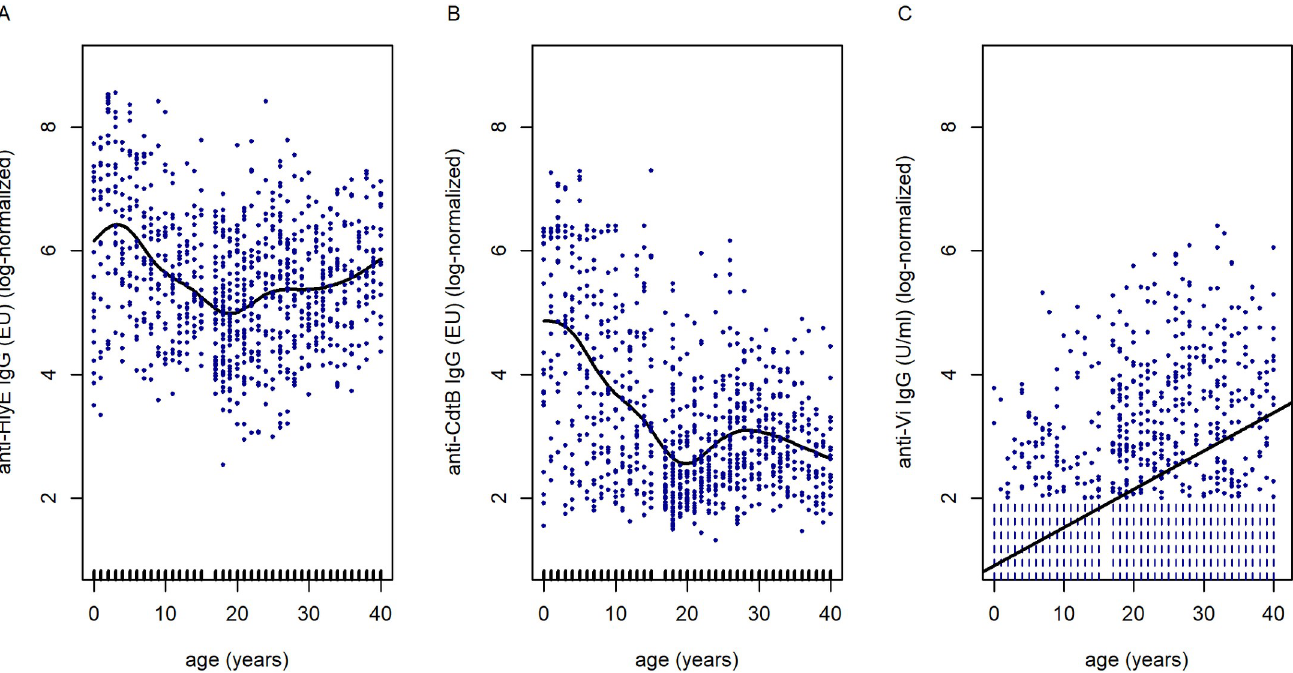
Fig 3. Results of generalized additive and linear models assessing anti– S . Typhi IgG antibody prevalence in children and adults in Lao PDR as a function of age. Non-linear smooths were fitted for age in the model for anti-HlyE IgG (A) and anti-CdtB IgG (B) data. The tick marks on the x-axis are observed data points. In panel C, the Akritas-Thiel-Sen regression line relating to the anti-Vi IgG titer data as function of age was plotted in order to account for the censored values (censored observations were plotted as vertical dashed lines). %dev. = the percent of the total model deviance explained.